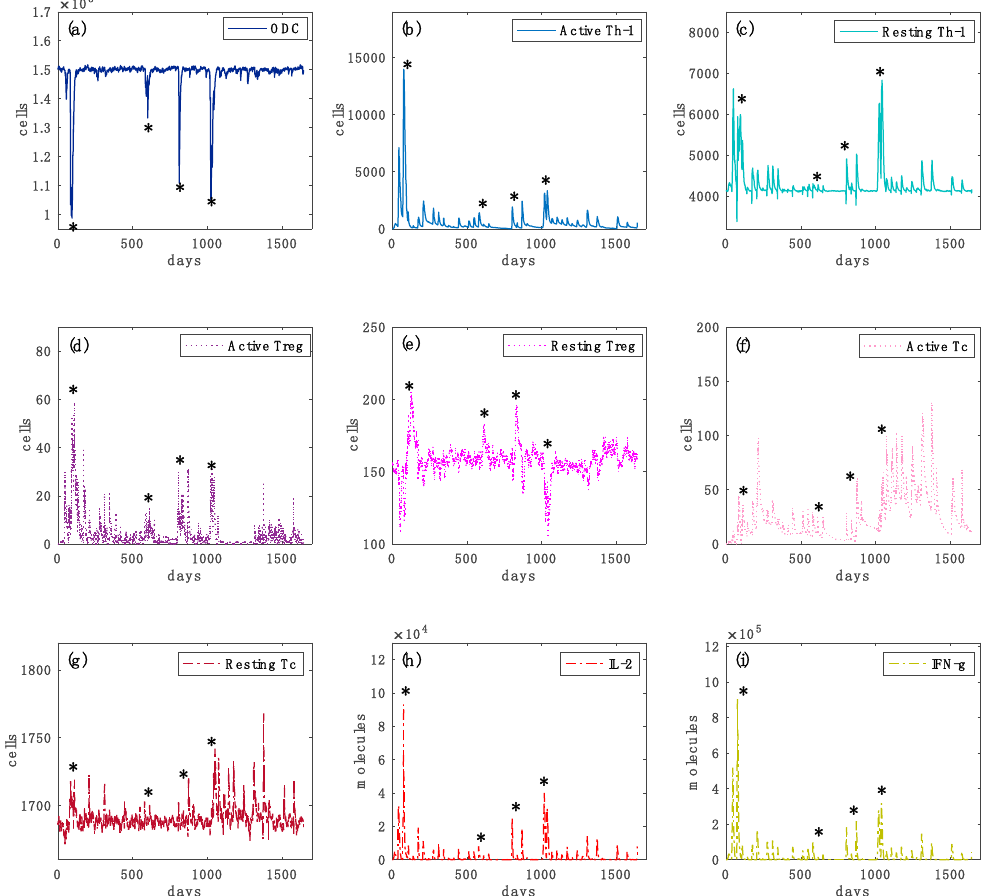
Figure 5. Simulated oligodendrocyte (ODC), Active T helper cells (Active Th-1), Resting T helper cells (Resting Th-1), Active regulatory T cells (Active Treg), Resting regulatory T cells (Resting Treg), Active cytotoxic T cells (Active Tc), Resting cytotoxic T cells (Resting Tc) populations and inflammatory cytokines Interleukin-2 (IL-2) and Interferon-gamma (IFN-g) dynamics for the virtual healthy control patient are respectively depicted in panels ( a – i ), respectively. In each panel, star symbols highlight the time-points at which relapses occur, i.e., the time points in which the level of ODC cells goes below the mentioned MRI detectable event threshold. In panel ( a ), one can notice di ff erent loss of oligodendrocytes levels that indicate specific relapse events. In panels ( b , c ), the levels of active Th-1 cells, which are potentially dangerous in inducing an auto-reactive immune response against oligodendrocytes, are much higher in comparison with the healthy case (Figure 4, panel ( a )). It is caused by an impaired regulatory T cells activity. In panels ( d , e ) the activation of regulatory T cells and their consequent activity in suppressing any auto-reactive immune response is noticeably insu ffi cient. In panels ( f , g ), active cytotoxic T cells levels are present, indicating a cytotoxic activity directed to oligodendrocytes. In panels ( h , i ), interleukin 2 (IL-2) and inflammatory interferon gamma (IFN-g) cytokines show su ffi cient levels to induce a strong inflammatory